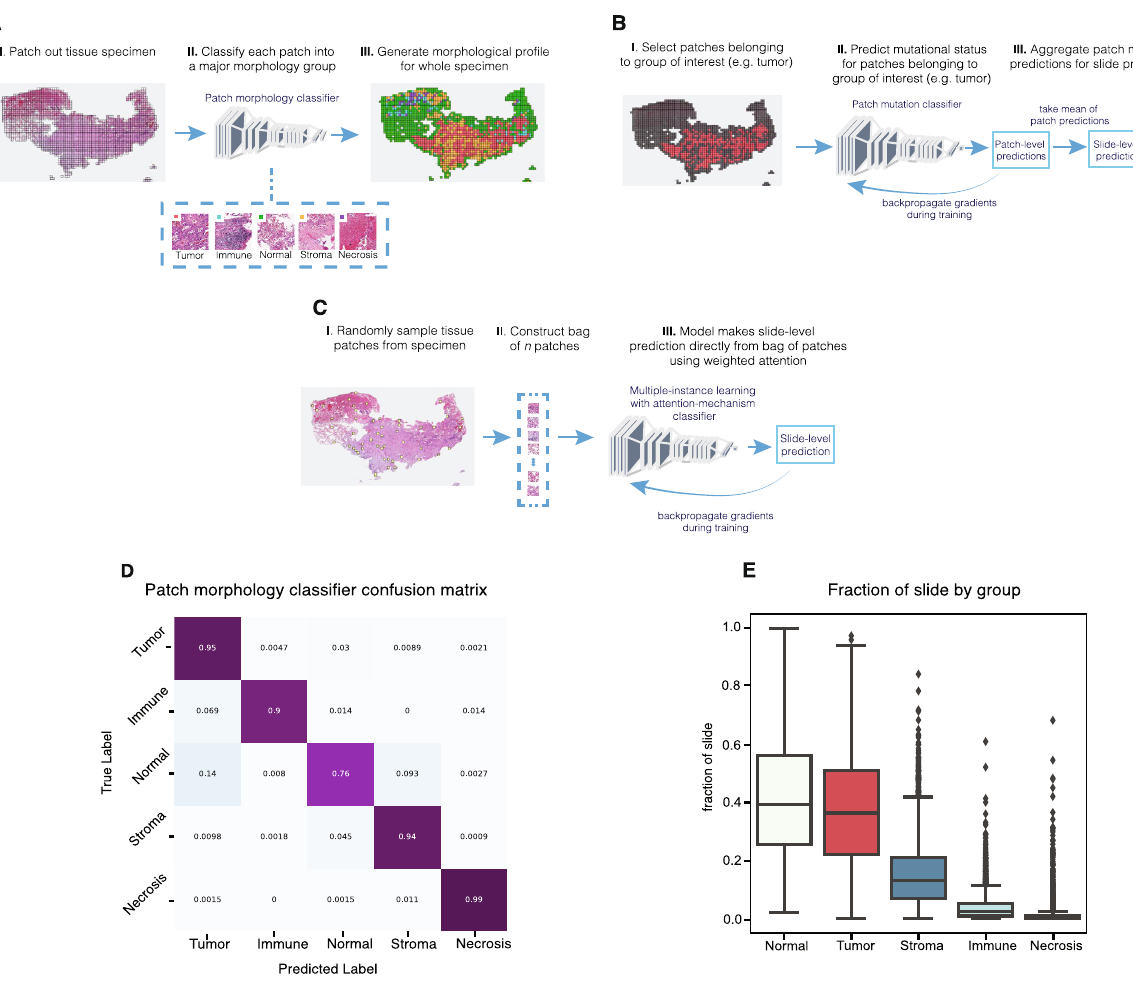
Figure 1. Various models to characterize and predict EGFR mutational status from specimens with highly diverse tissue morphologies. (a) A deep learning tissue morphology model that produces broad patch-level classifications for all patches from a slide. (b) A deep learning modeling approach to predict EGFR mutational status at a slide-level by utilizing patches belonging to a specific predicted tissue group only and aggregating patch predictions for the final output. (c) A multiple-instance learning approach that utilizes an attention mechanism, allowing for machine-intuition to automatically weigh patches of interest when directly predicting EGFR mutational status for the slide using a bag of patches. (d) Confusion matrix for the patch-level tissue morphology classifier that categorizes each patch given its predominant tissue morphology. (e) The distribution of tissue morphologies exhibited across the real-world lung adenocarcinoma cohort (n = 2099) as classified by the tissue morphology